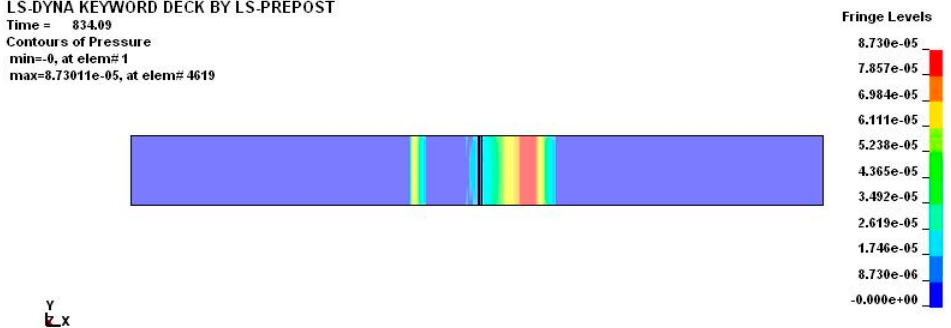
Figure 11. The model in LSDYNA for Taylor’s problem. The rigid plate with water on one side and with air on the other side.